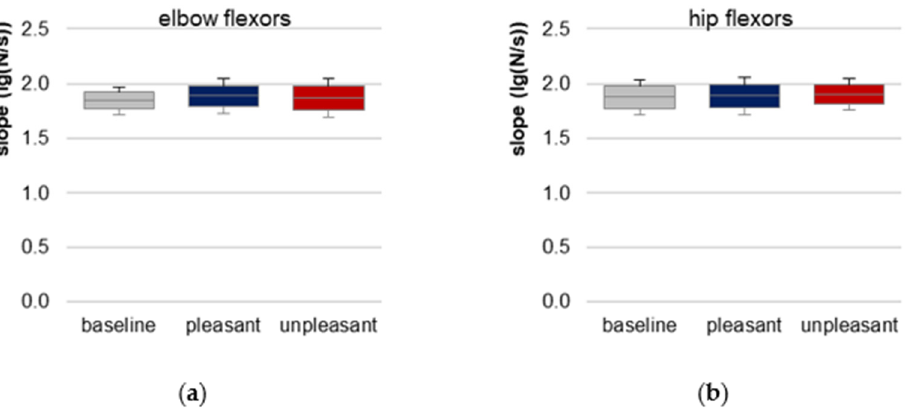
Figure 4. Slope. Arithmetic means, standard deviations (error bars) and 95% confidence intervals (CIs) of the logarithmic slope (lg(N/s)) comparing baseline (grey), pleasant (blue) and unpleasant (red) imagery of ( a ) elbow and ( b ) hip flexors are displayed. Statistical comparisons were non-significant ( p > 0.05). Table 1. Descriptive and statistical results of AF parameters. Arithmetic means (M), standard de- viations (SD), lower and upper border of 95% CIs as well as p values and effect sizes η 2 or Kendall’s W of the AF parameters for baseline, pleasant and unpleasant imagery of elbow and hip flexors are given. Parameter